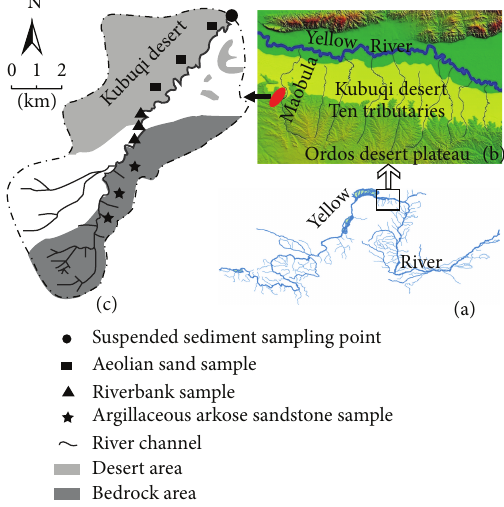
Figure 1: The location of the Sudalaer desert stream and sampling site. (a) shows the Yellow River; (b) locates the ten tributaries that originate in the high Ordos desert plateau, flow across the Kubuqi desert from south to north, and transport sediment to the Yellow River; (c) shows the Sudalaer desert stream and the sampling site.